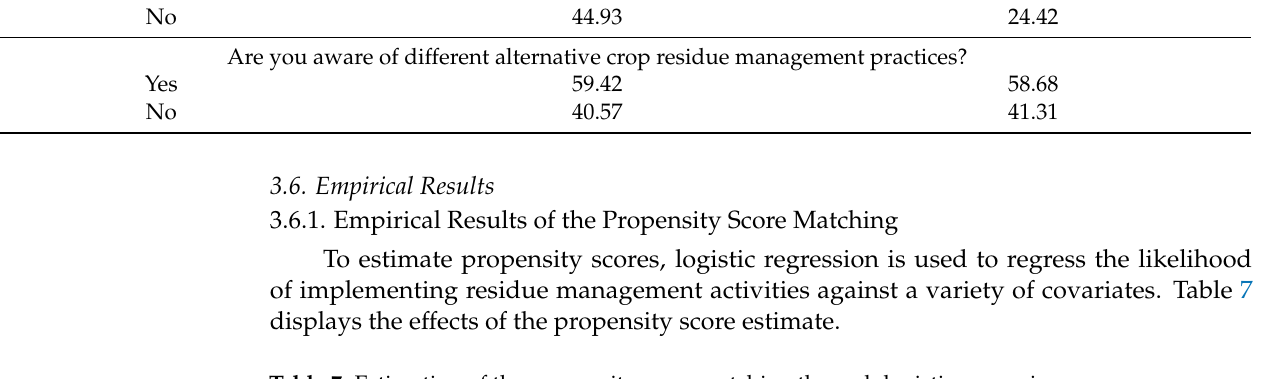
Table 7. Estimation of the propensity score matching through logistic